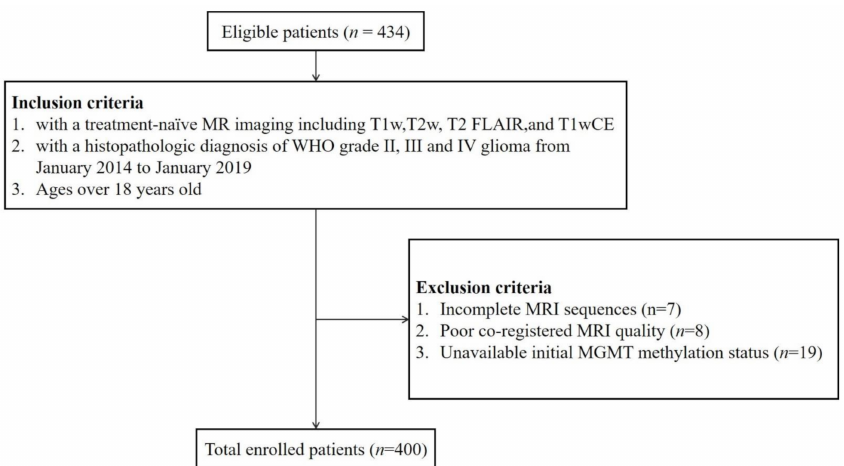
Figure 1. Patient inclusion and exclusion criteria. Abbreviations: T1w, T1-weighted imaging; T2w, T2-weighted imaging; T1wCE, contrast-enhanced T1-weighted imaging; FLAIR, fluid-attenuated inversion